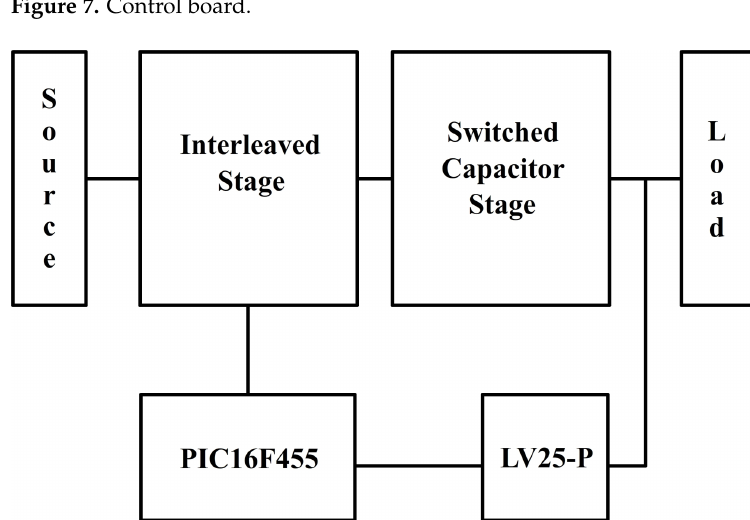
Figure 7. Control board.